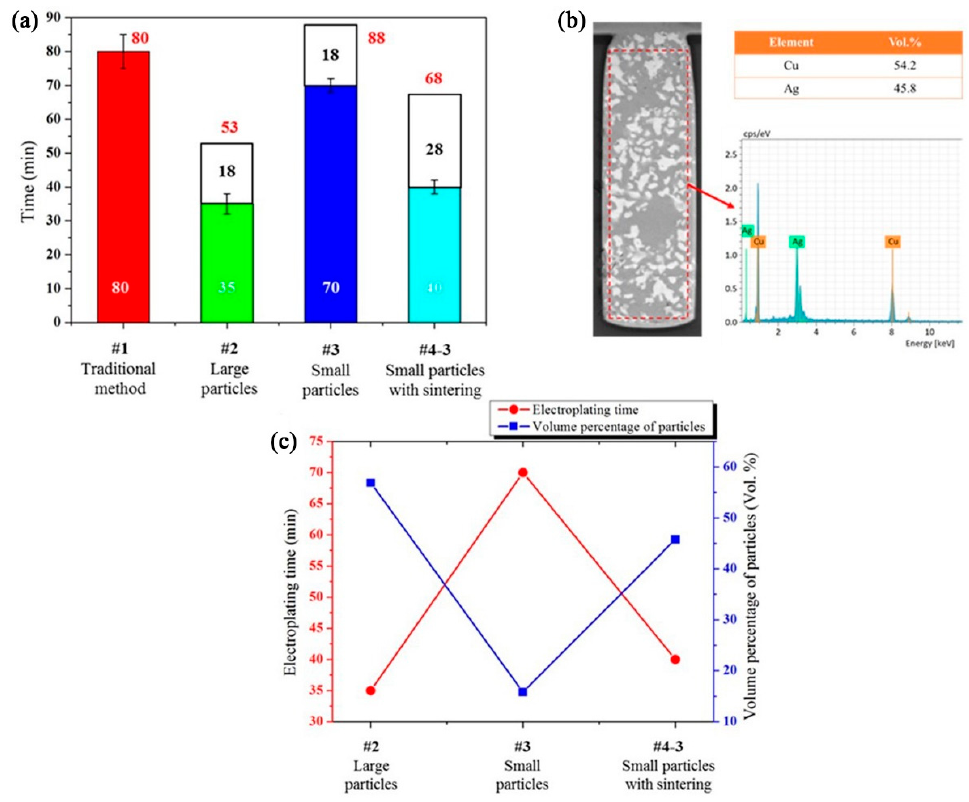
Figure 4. ( a ) Filling time of microvias using different methods, ( b ) particle content detected by EDS, ( c ) relationship between electroplating time and particle contents. ( c ) relationship between electroplating time and particle